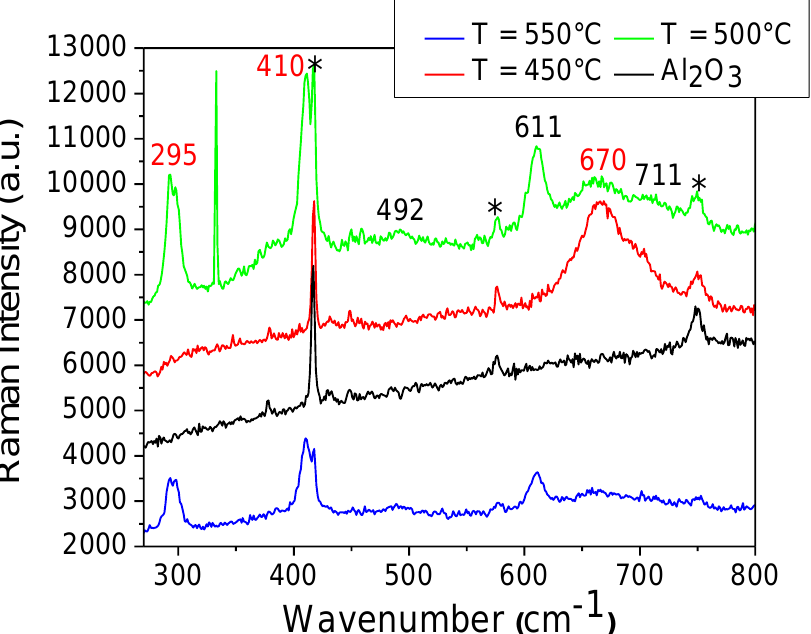
Figure 6. Raman spectra of Fe 3 O 4 films on Al 2 O 3 (0001), where * indicates substrate peaks, numbers in red indicate the approximate peak positions of the Fe 3 O 4 phase and the numbers in black indicate α-Fe 2 O 3.